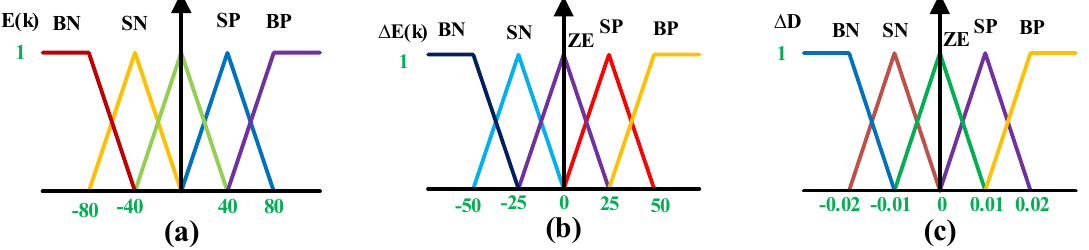
Figure 10. ( a ) Input; ( b ) change in input and ( c ) output membership functions.